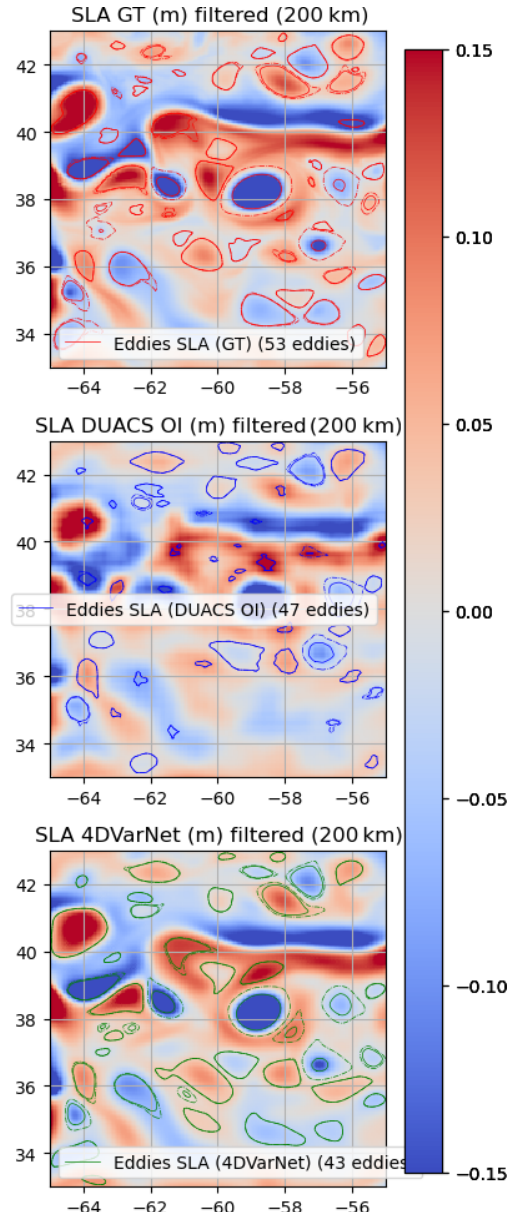
Figure C1. Eddies detected on the GULFSTREAM domain (25 October 2012) over SSH (four